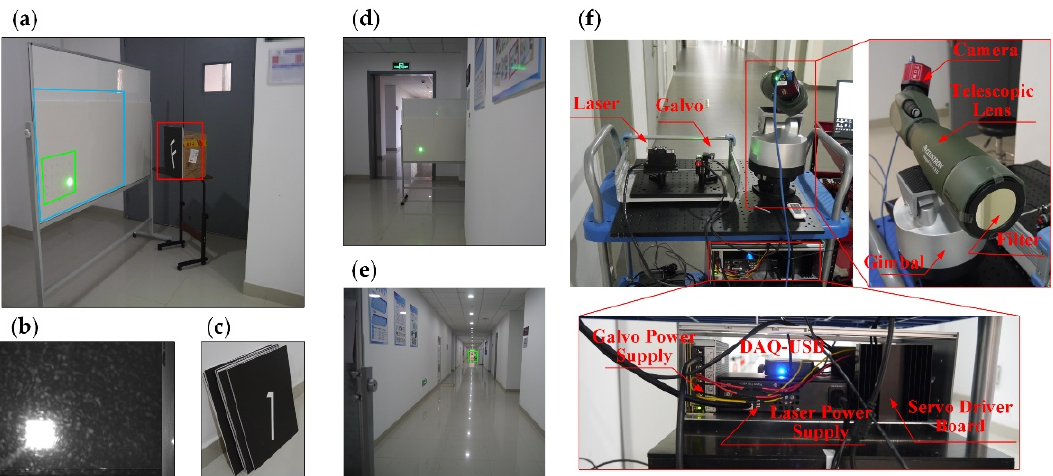
Figure 6. Setup of the NLOS scene and experimental system: ( a ) NLOS scene setup; ( b ) camera field of view (FOV); ( c ) hidden object; ( d ) obstructed view; ( e ) experimental system setup position; ( f ) experimental system setup.